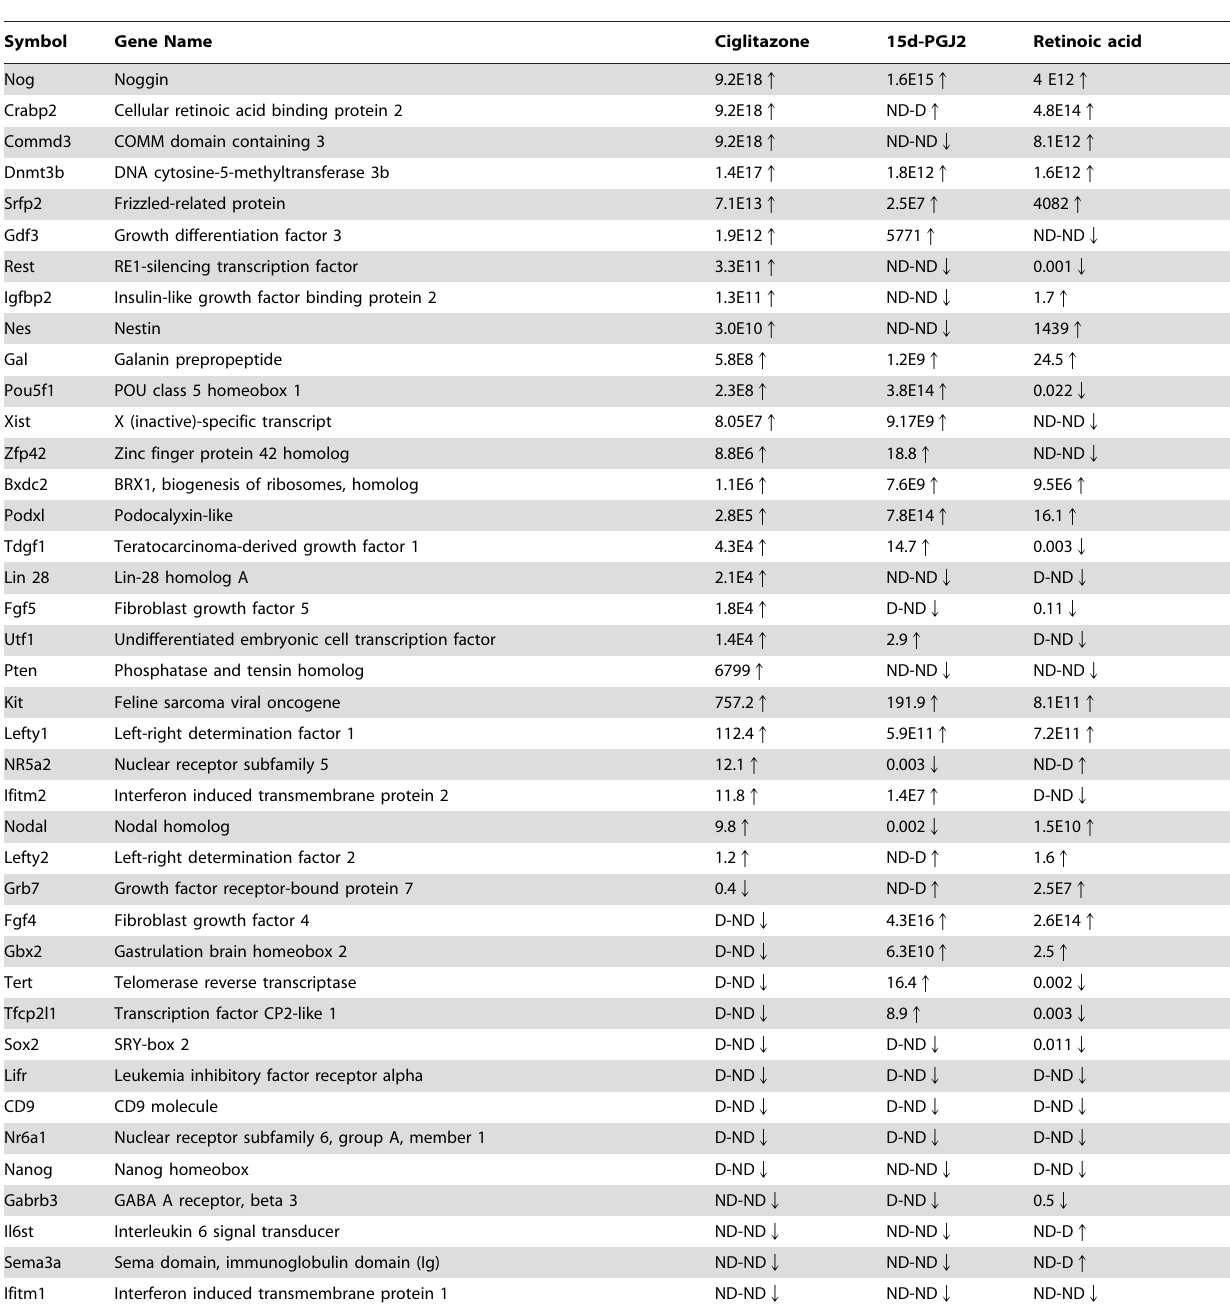
Table 1. Regulation of stemness gene profile by PPAR c agonists in neural stem cells.